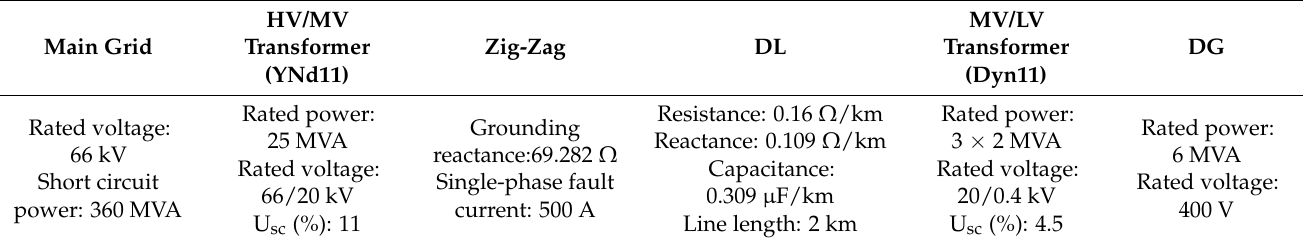
Table 1. Grid parameters.